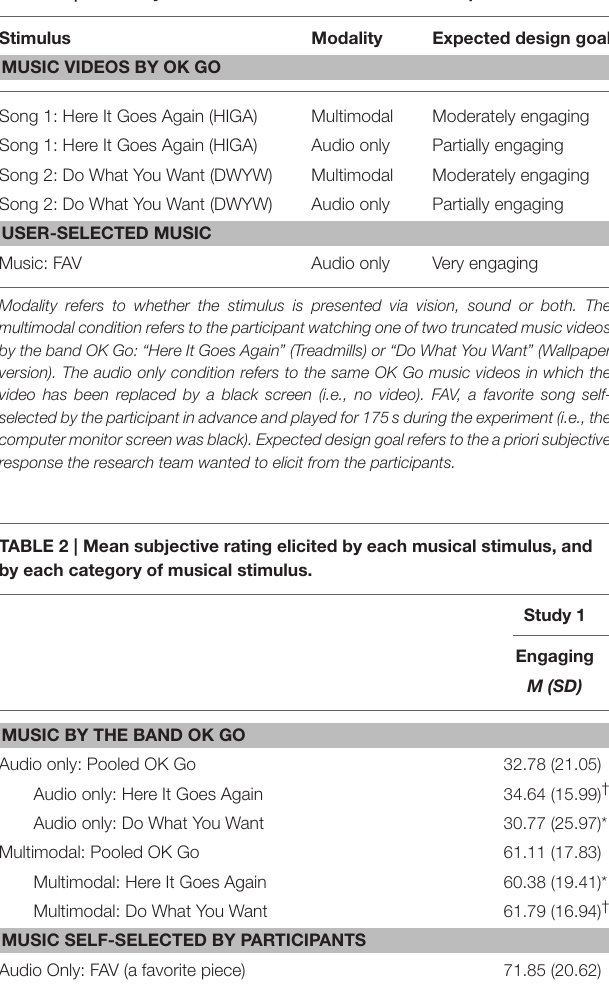
TABLE 1 | Summary of the musical stimuli used in this experiment.